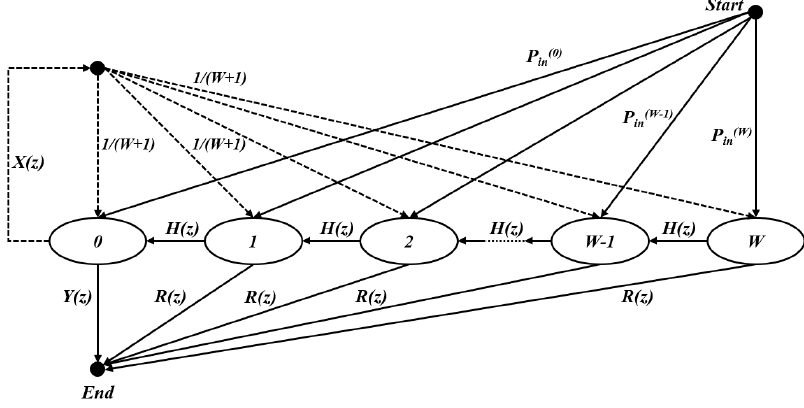
Figure 6. The generalized state transition diagram for the proposed